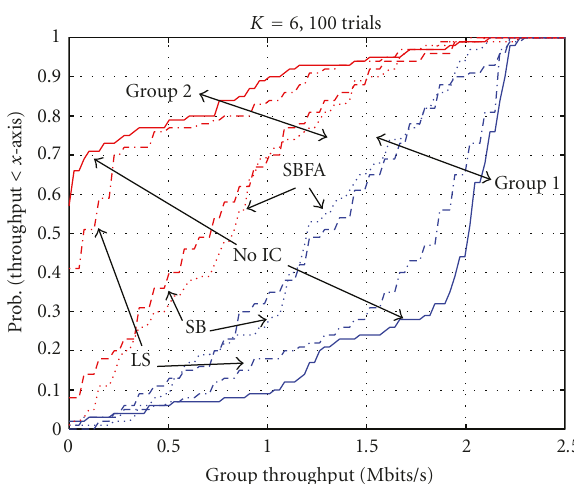
Figure 12: Throughput CDF for the residential scenario of Figure 5.